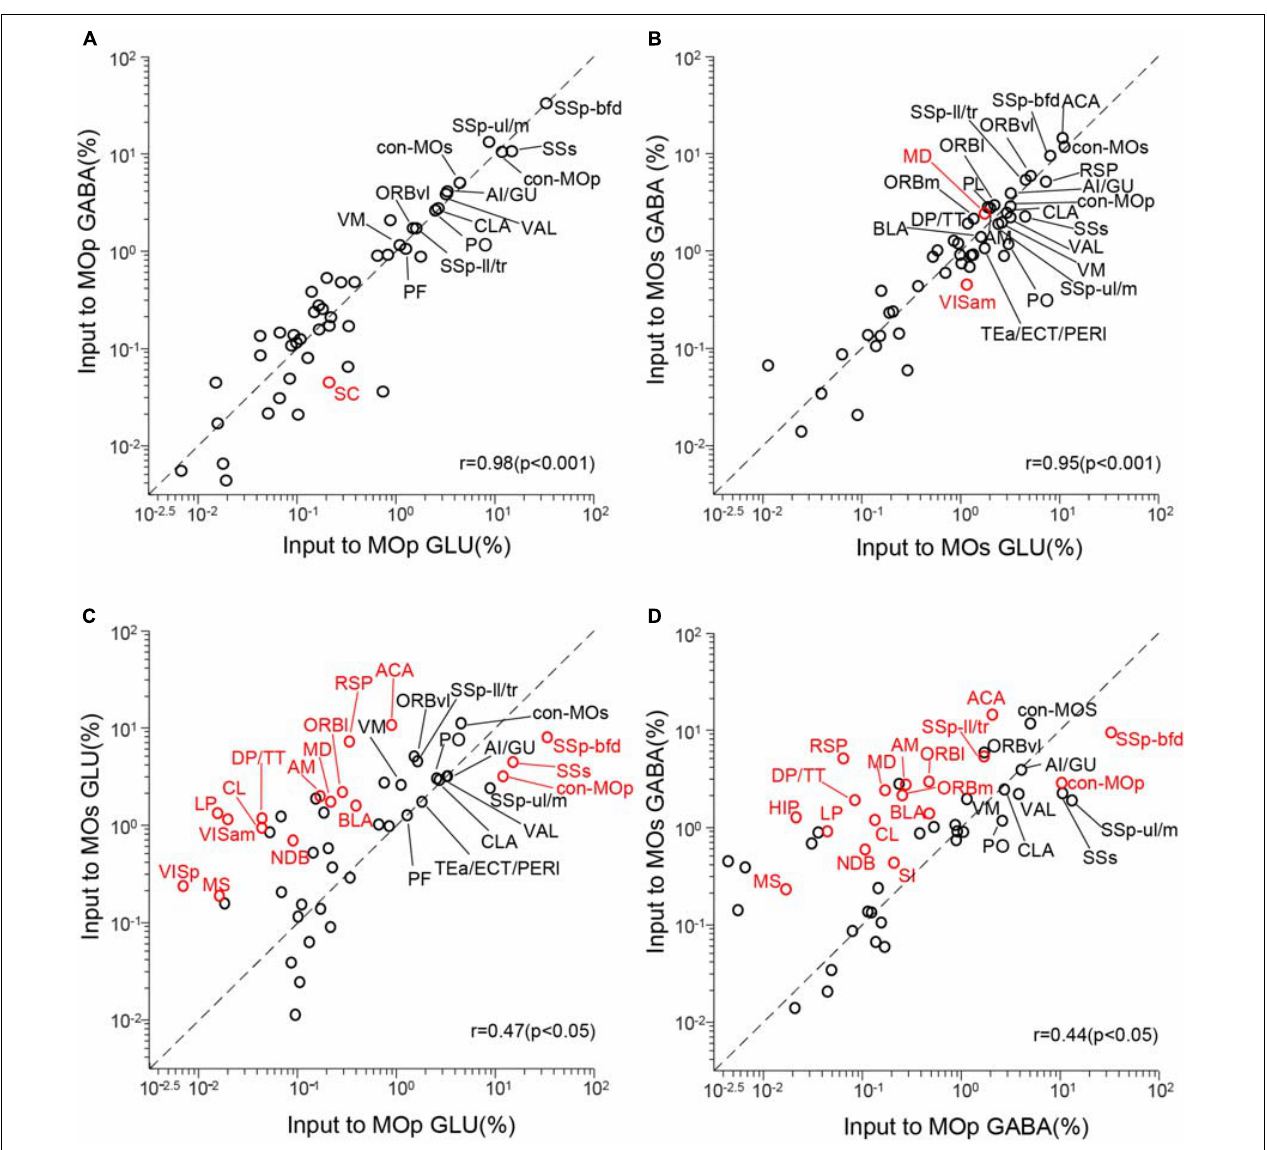
FIGURE 4 | Comparisons of monosynaptic inputs to motor cortex. (A) Comparison between inputs to the glutamatergic neurons (GLU) and GABAergic neurons (GABA) in the MOp. (B) Comparison between inputs to the GLU and GABA in the MOs. (C) Comparison between inputs to the GLU in the MOp and MOs. (D) Comparison between inputs to the GABA in the MOp and MOs. Values are the means of the percentage of the total inputs from each region. Red circles indicate significant differences ( P < 0.05, corrections for multiple comparisons with Tukey’s Honest Significant Difference test). r: Pearson’s correlation coefficient.